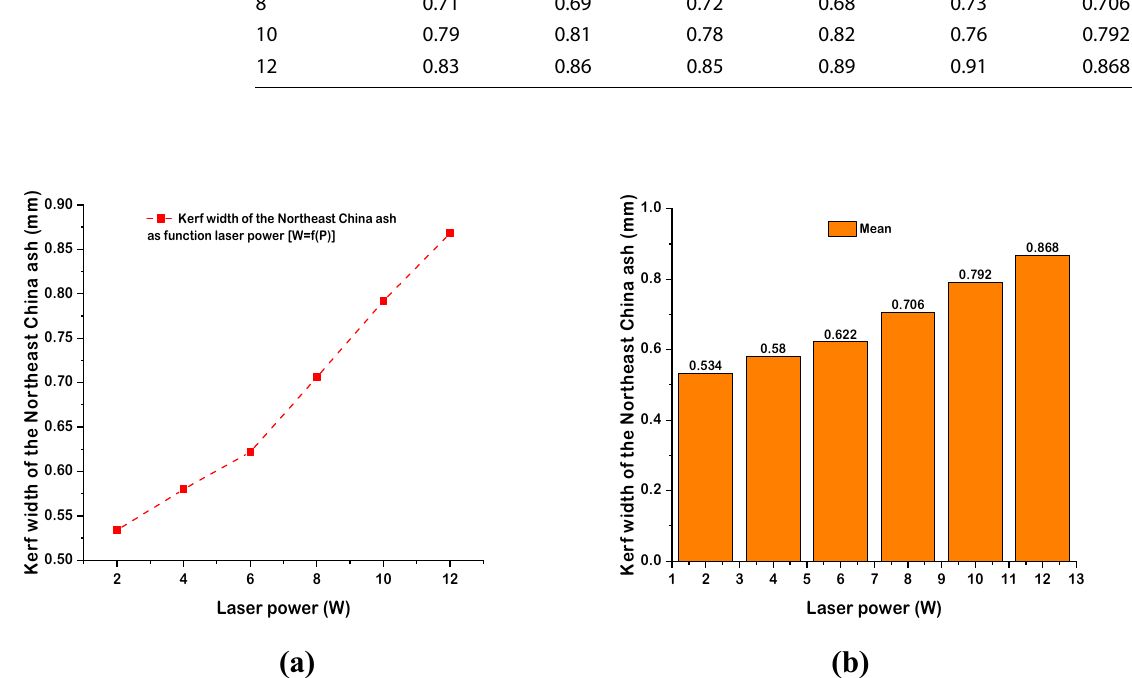
Fig. 11 Kerf width as a function of laser power of Fraxinus mandshurica [ W = f (P) ] a Kerf width variation of Northeast China ash, b Histogram of kerf width versus laser power